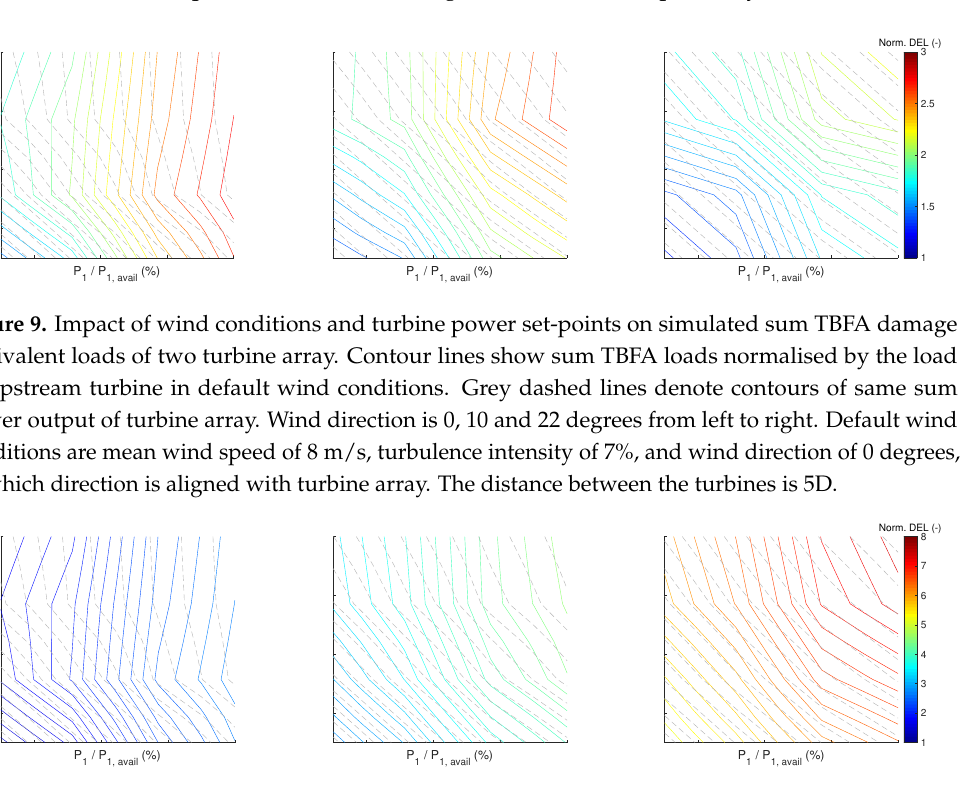
Figure 10. Impact of wind conditions and turbine power set-points on simulated sum Tower Bottom Fore-Aft (TBFA) damage equivalent loads of two turbine array. Contour lines show sum TBFA fatigue normalised loads. Ambient turbulence intensity is 7%, 14% and 27% from left to right.